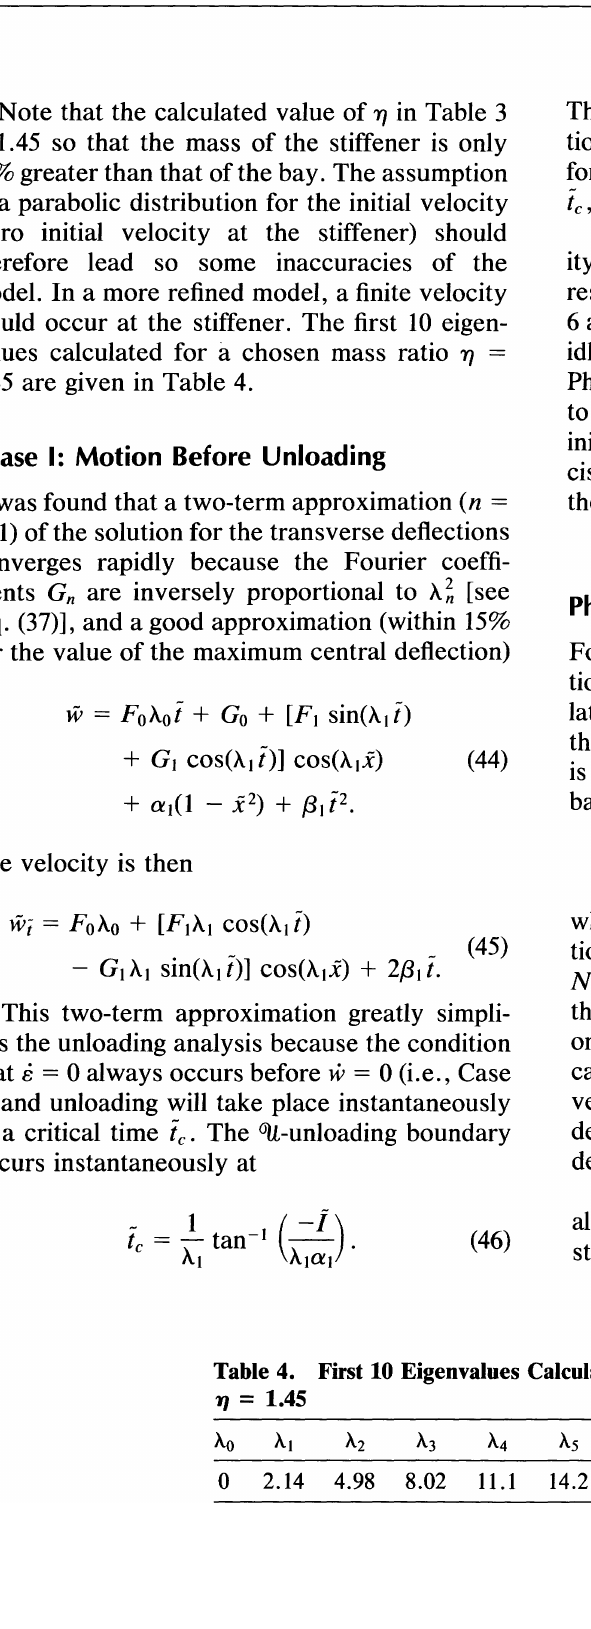
Table 3. Calculated Quantities for the Shell if